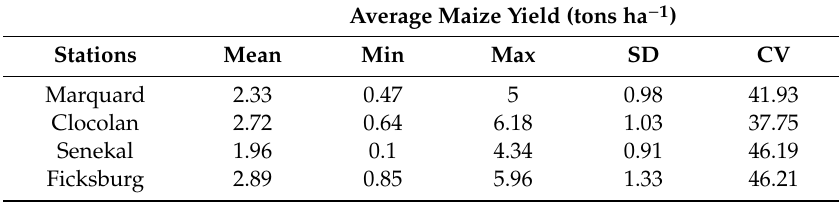
Figure 2. The annual maize yield (tons ha −1 ) for the four stations in the Setsoto municipality from 1985 to 2016 used for this study. Table 4. The average maize yield (tons ha − 1 ) for the four stations in Setsoto Municipality from 1985–2016 used for this study.